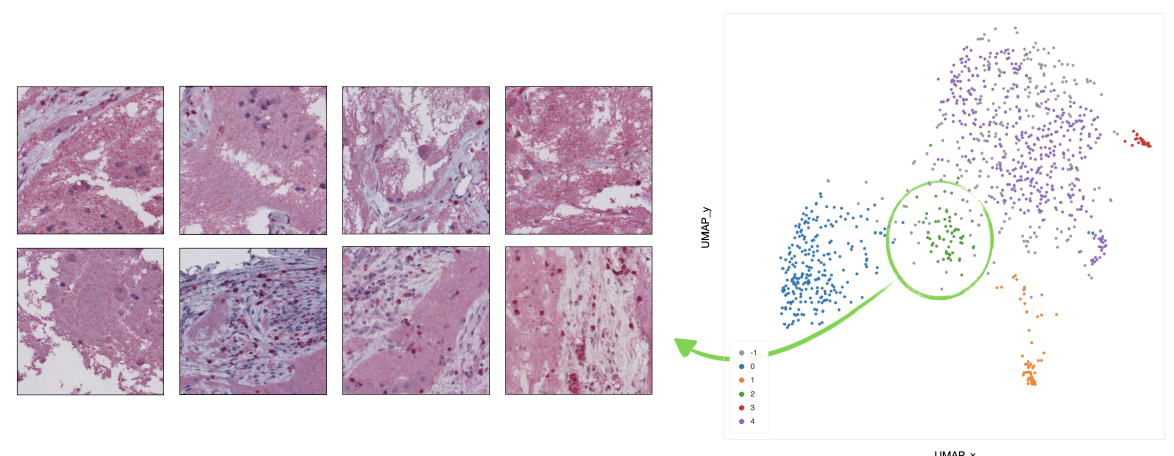
Figure 11. Example of 8 representative tiles with infiltration of lymphocytes in pseudo-necrotic tissue , grouped as cluster 2 by UMAP and